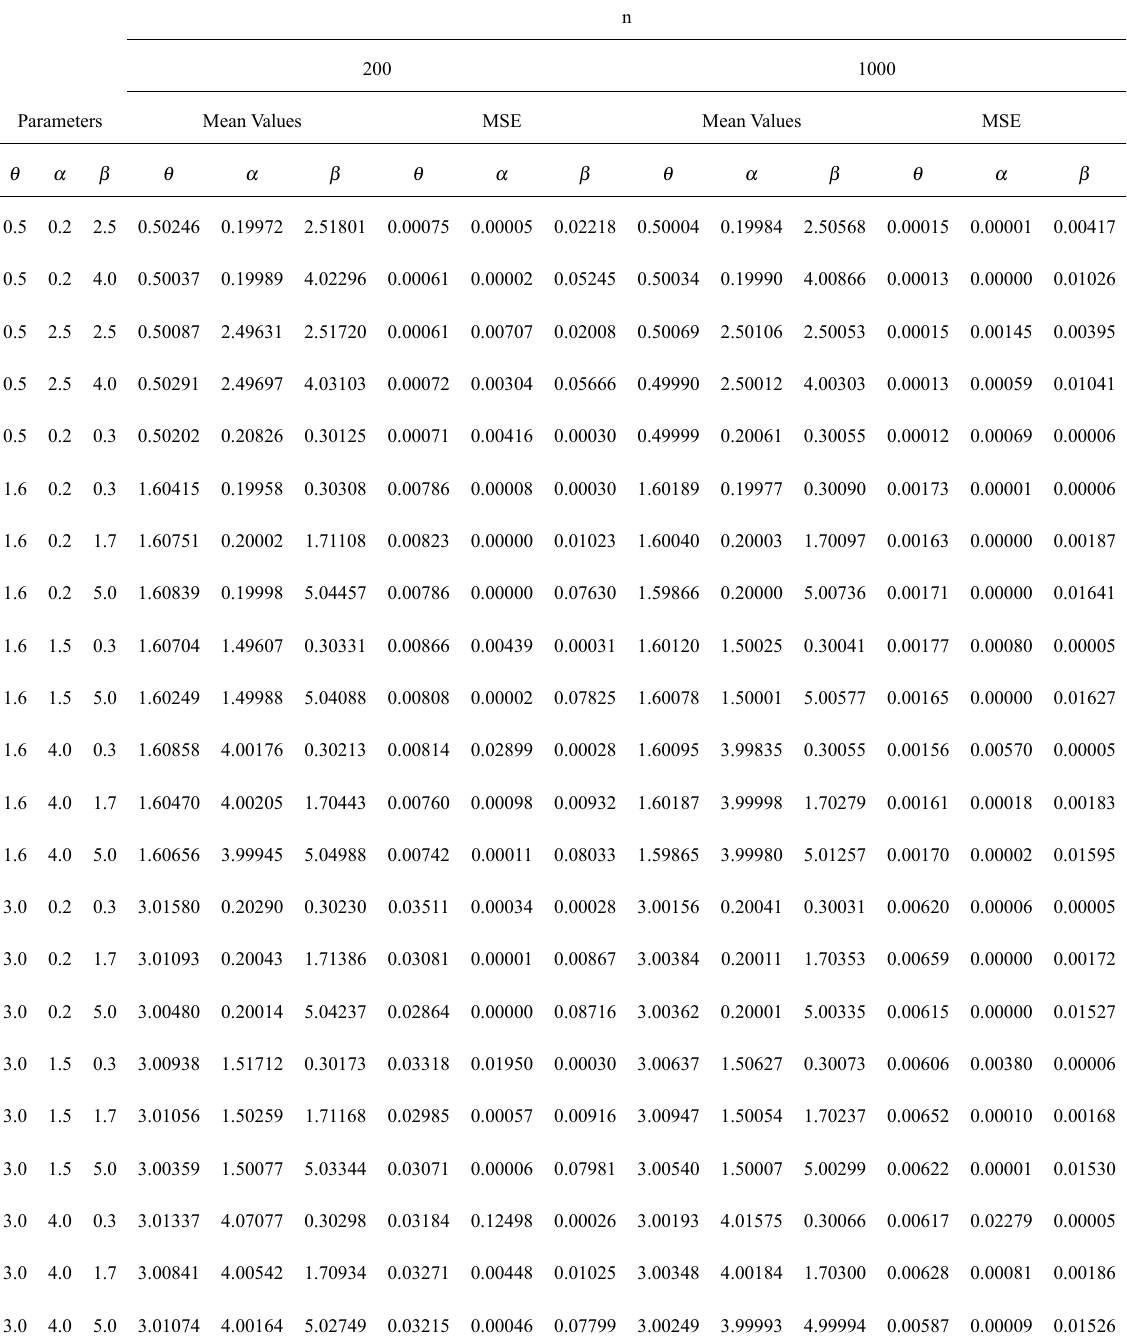
The mean values and MSEs based on 1,000 simulations of the LiW